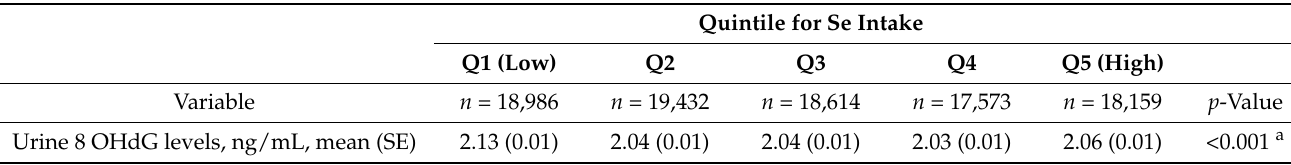
Table 2. Maternal 8-hydroxy-2 (cid:48) -deoxyguanosine (8-OHdG) urine levels during pregnancy according to the preconception Se intake quintiles.